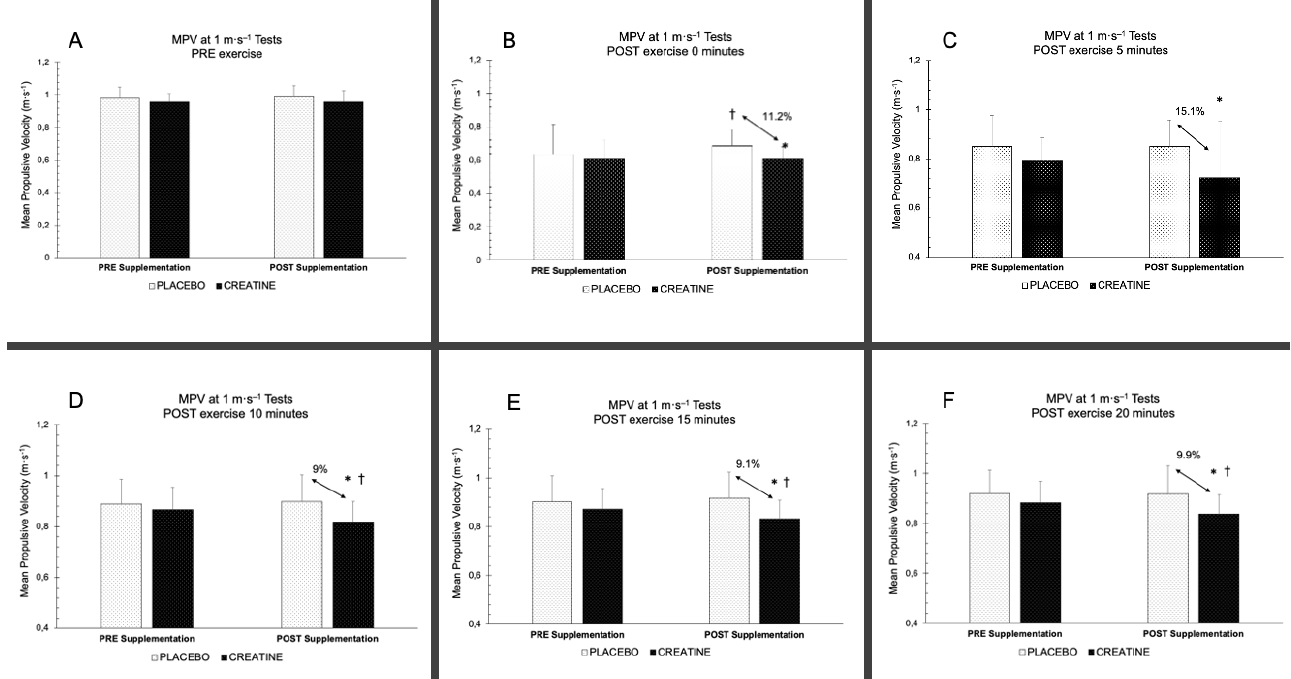
Figure 4. MPV in the 1 m·s − 1 test in pre- and post-exercise in the CR and PLA groups before and after the supplementation period. † = significant difference between pre- and post-supplementation periods ( p < 0.05). * = significant difference between groups ( p < 0.05). MPV = Mean Propulsive Velocity.